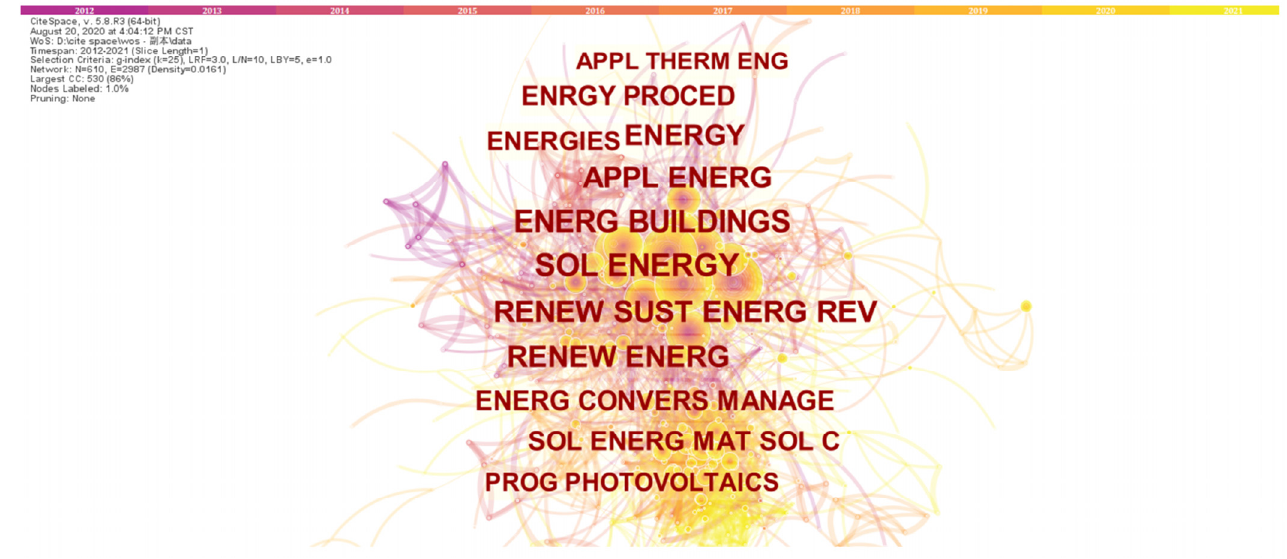
Figure 3. Co ‐ occurrence map of sources. Table 3. The co ‐ occurrence of the top ten